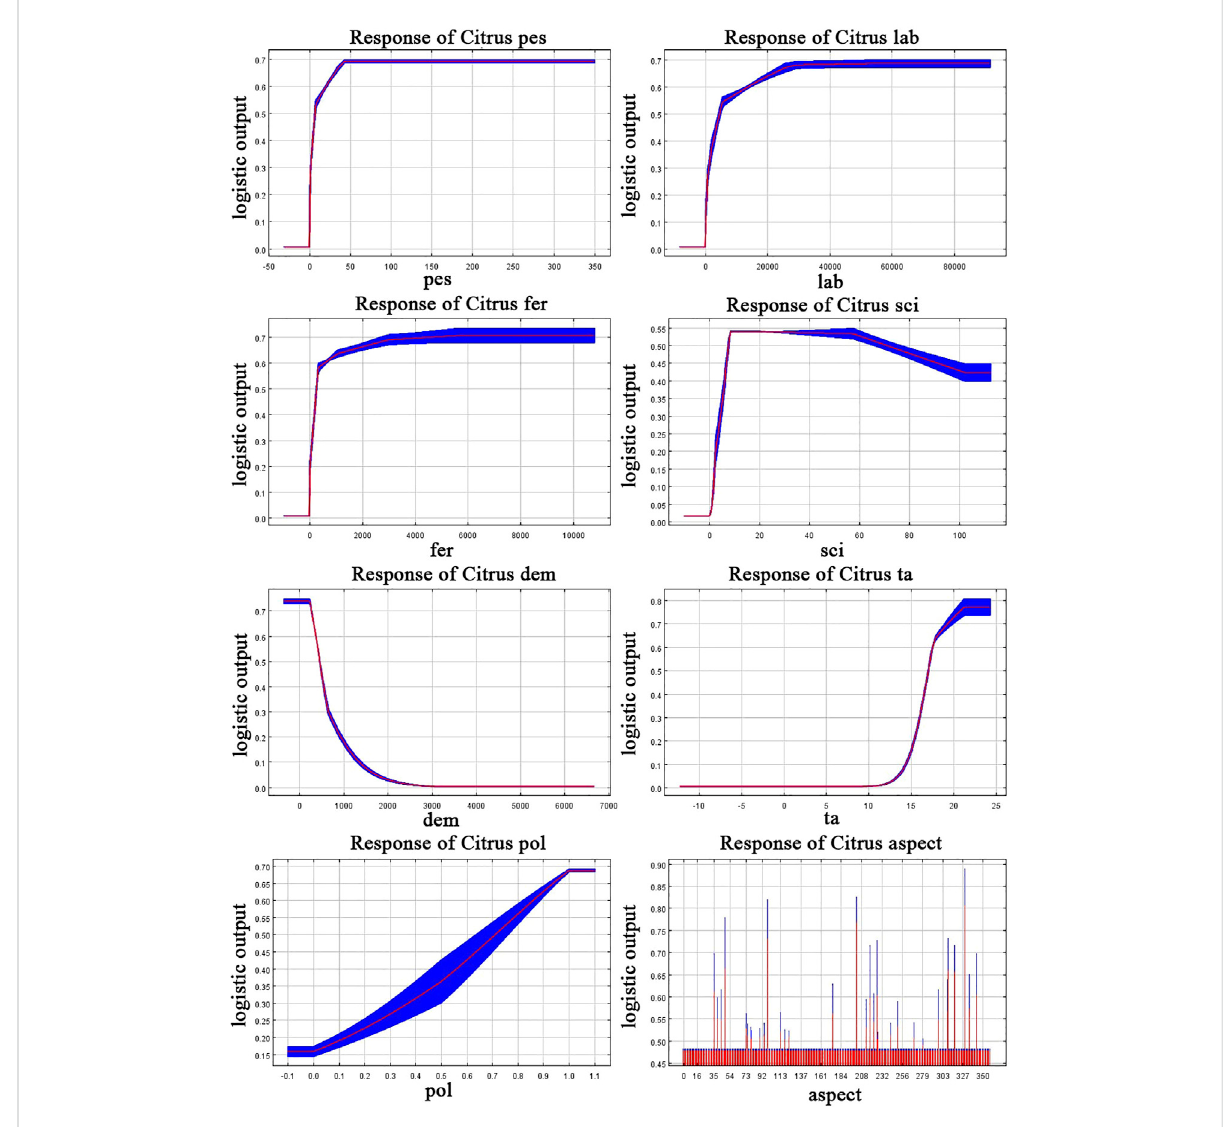
FIGURE 5 Response curves of existence probability of